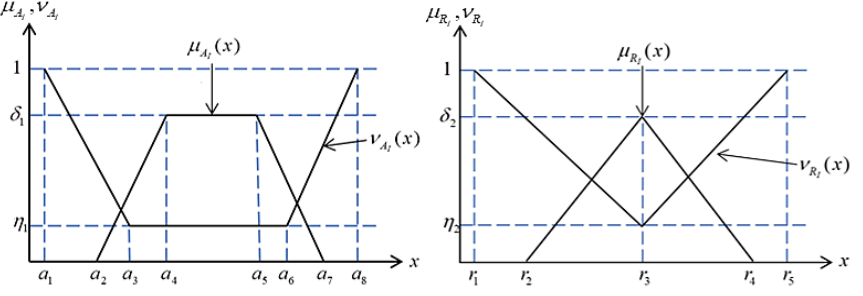
Fig. 3. An Intuitionistic Z-Number (IZN)